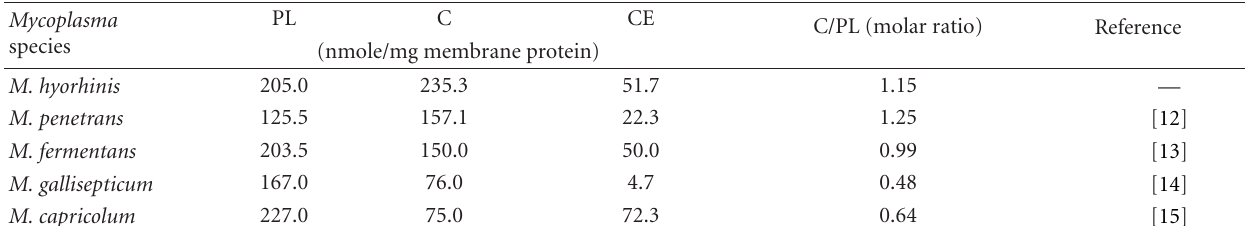
Table 1: Phospholipids and cholesterol in the cell membrane of representative Mycoplasma species. Mycoplasma